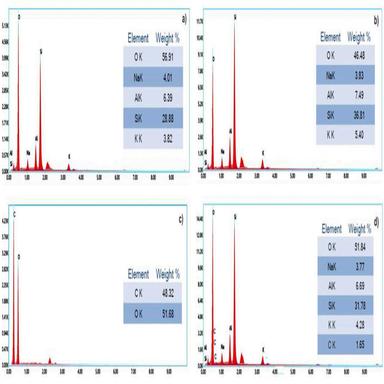
EDX analysis of samples (a: Expanded raw perlite; b: Acid-treated perlite; c: Graphene oxide; d: Perlite@GO).